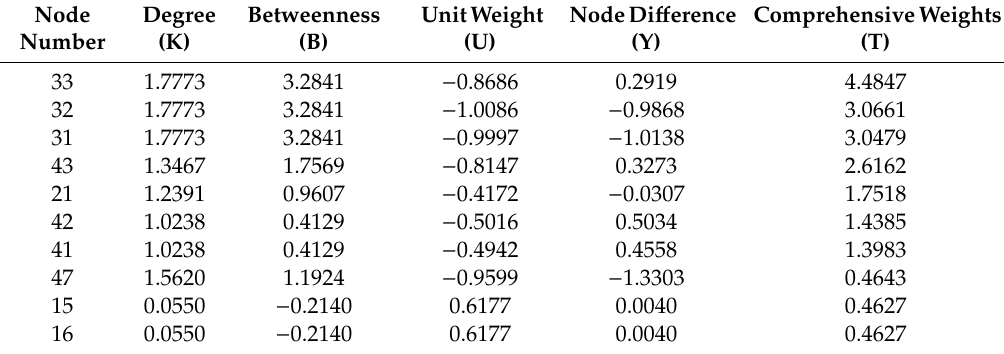
Table 8. Structural characteristics and comprehensive weights of the railway transportation